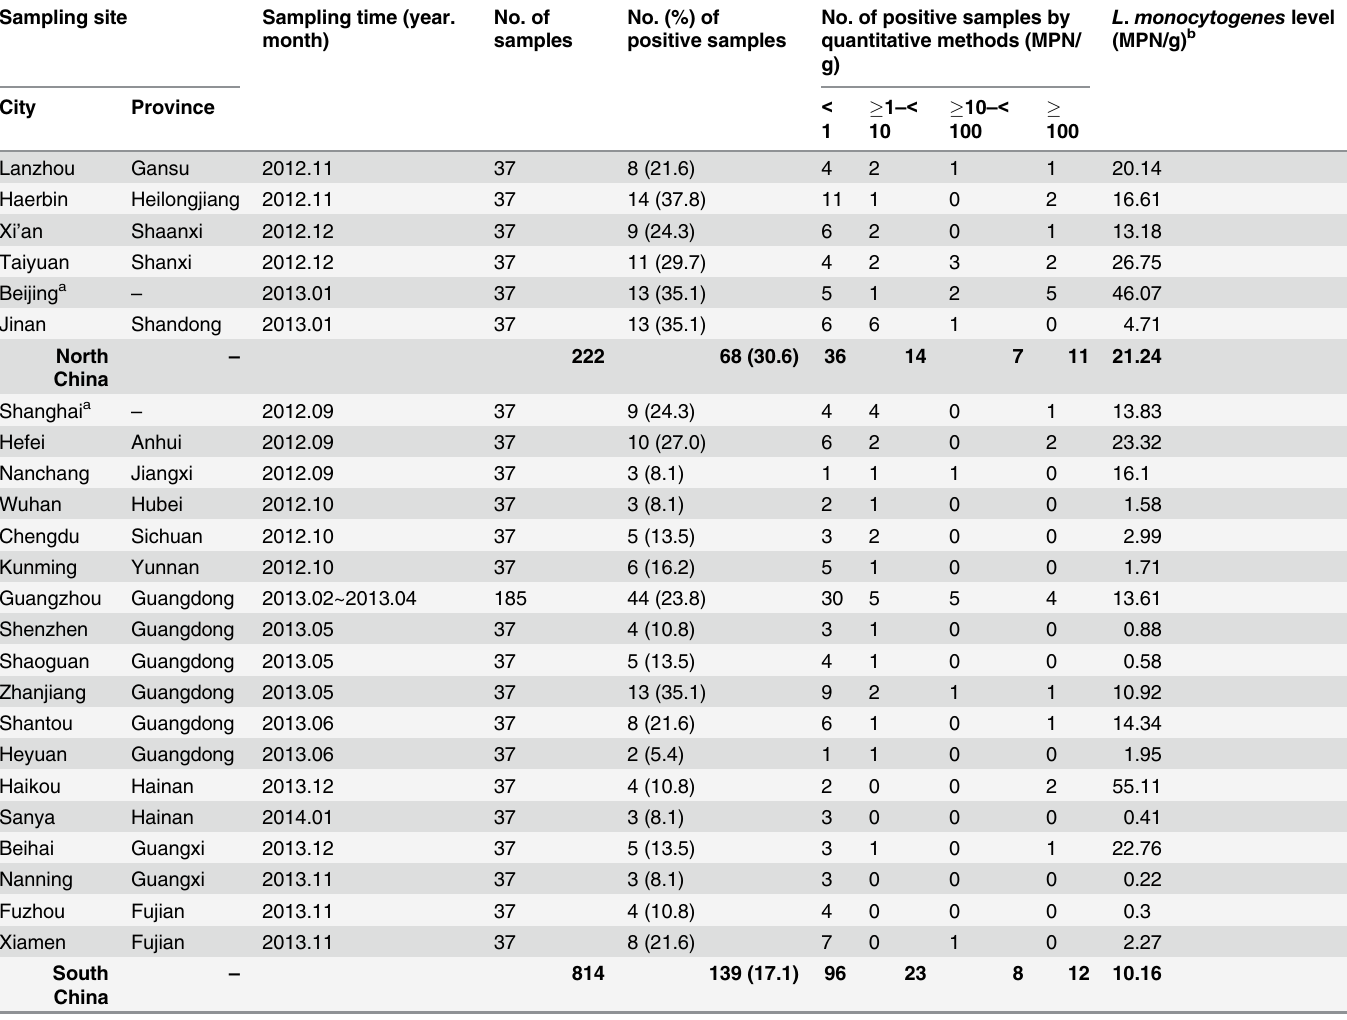
Table 2. Prevalence and level of Listeria monocytogenes at different sampling